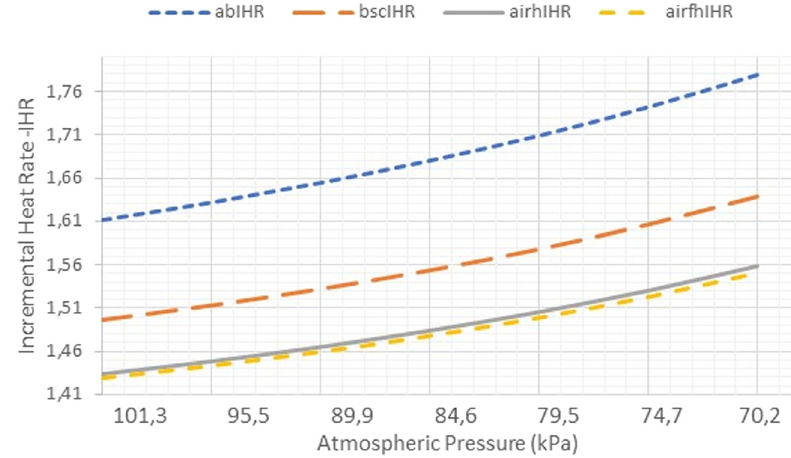
Figure 9: Variation of the IHR with atmospheric pressure for ab, bsc, airh, and airfh cogeneration systems.